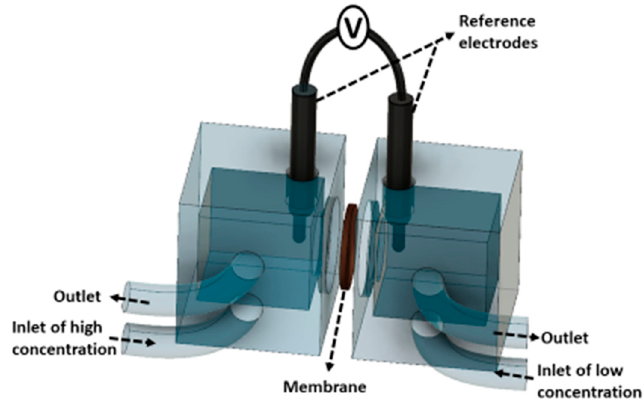
Figure 4. Scheme of the two compartments / two electrodes cell used for membrane potential measurements.